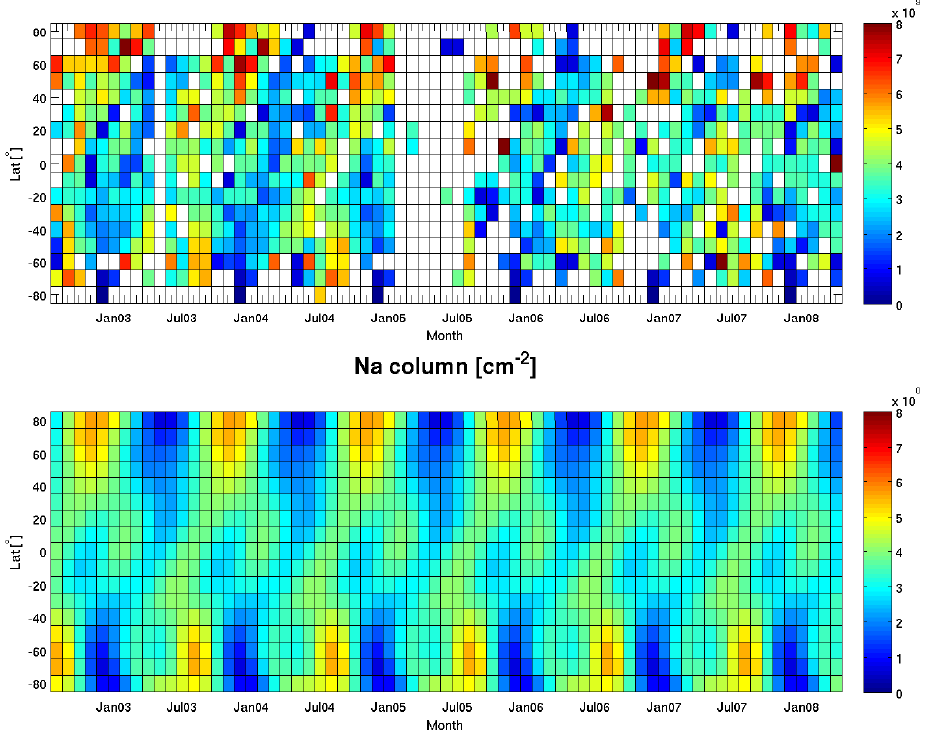
Fig. 9. Top: raw GOMOS Na columns (in units of cm − 2 ) retrieved between August 2002 and June 2008. Bottom: best fit according to Eq. (8). Notice the semi-annual cycle at low latitudes and the annual cycle in the polar regions.